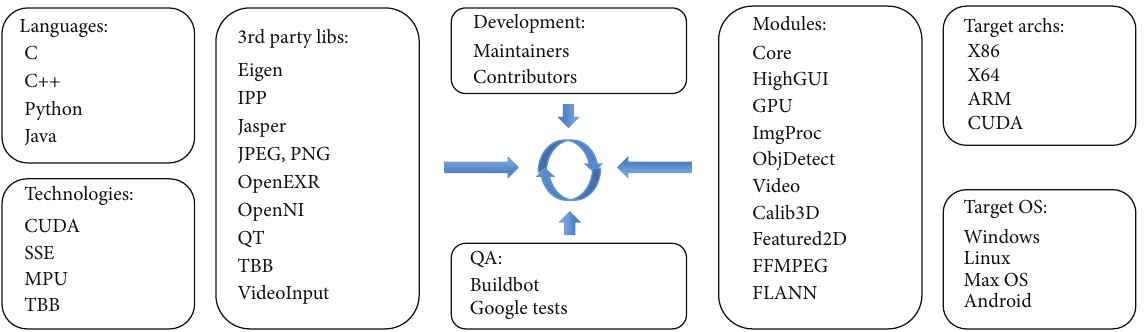
Figure 2: OpenCV architecture and library